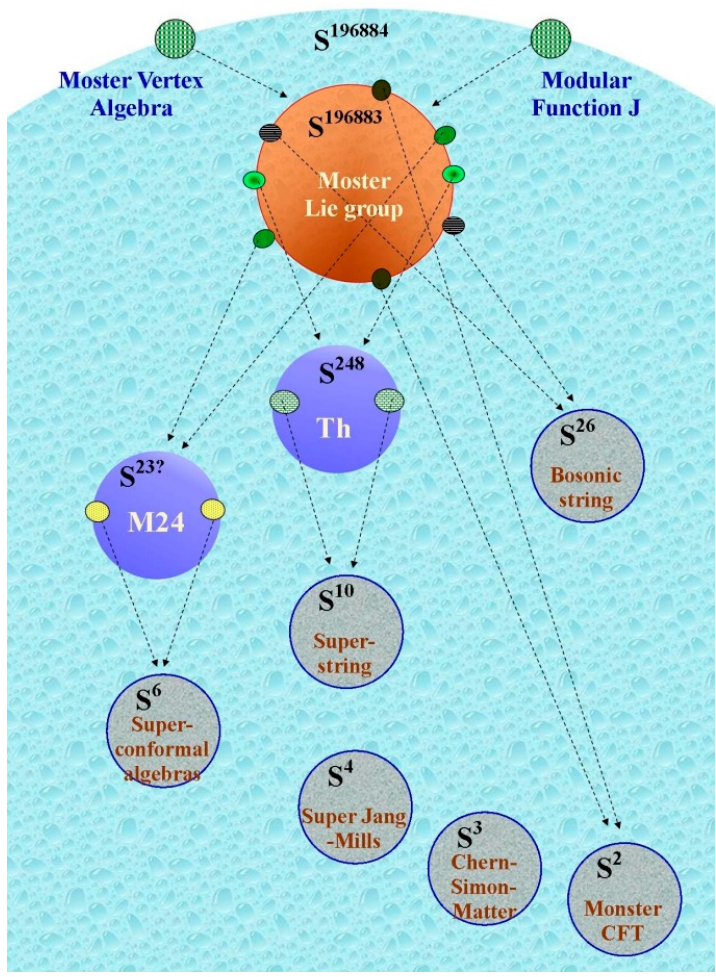
Figure 3. Progressive loss of dimensions in sporadic groups can be encompassed in a Borsuk–Ulam Theorem framework. Note also the loss of symmetries from the highest dimension levels to the lowest ones. The Figure also illustrates how every sporadic group might display a theoretical physical counterpart.